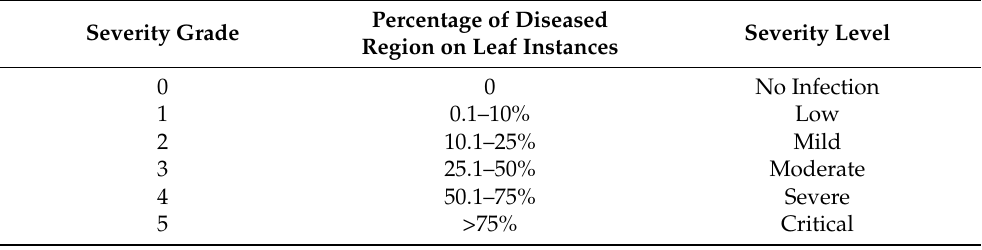
Table 4. The disease severity index of rice grade modeler of rice images used for the proposed